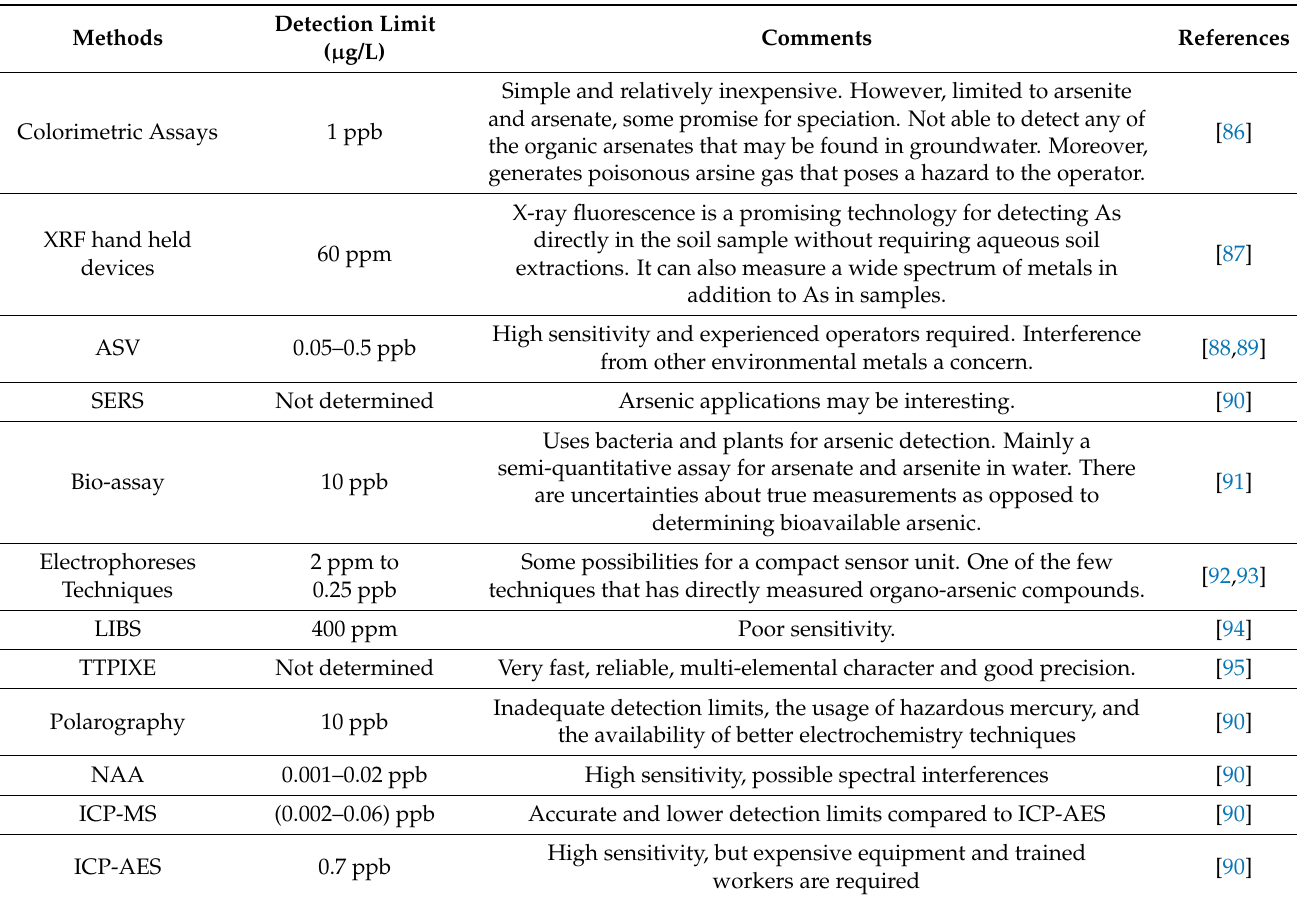
Table 8. Different detection methods of arsenic